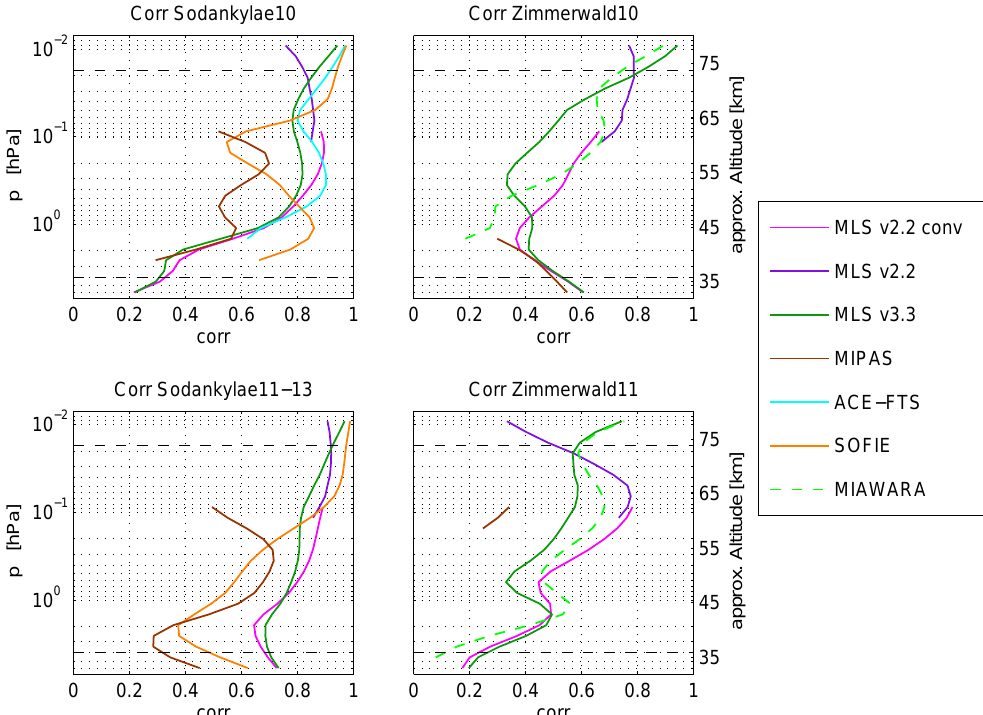
Fig. 16. Summary of all correlation coefficients for both campaigns. All plots use MIAWARA-C data with AoA > 0.5. The dashed horizontal lines indicate the reliable altitude range (AoA >